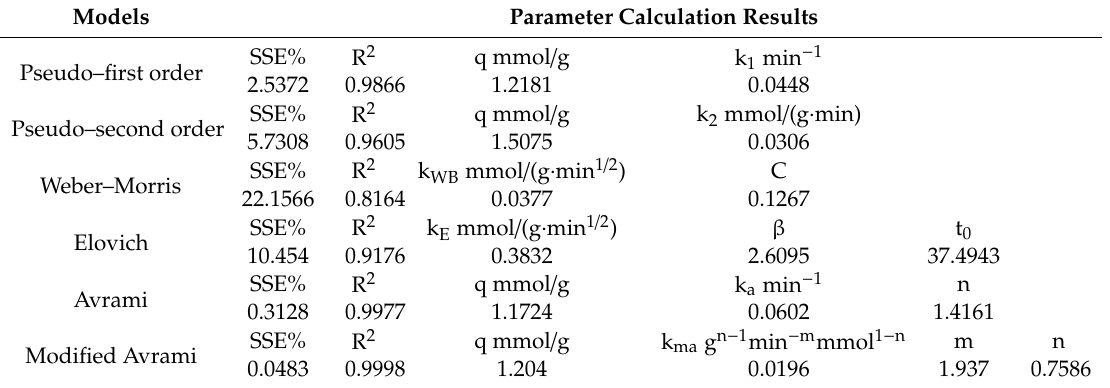
Figure 5. Fitting results for experimental data of six models. Table 3. Fitting parameters for experimental data of six models